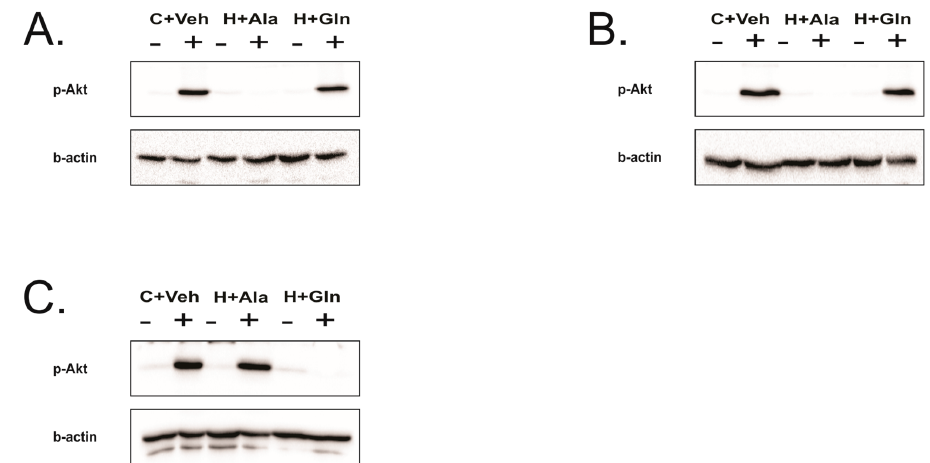
Figure 4. Insulin signaling in the liver, muscle, and adipose tissue. Akt phosphorylation in response